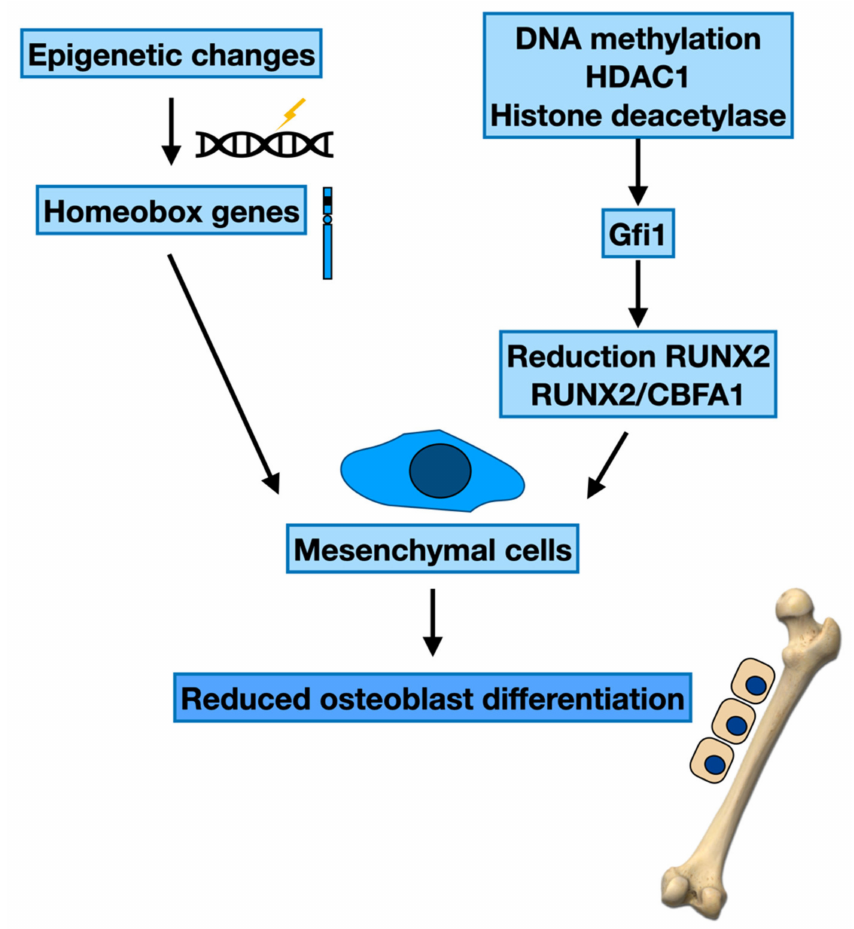
Figure 1. Epigenetic modifications and maturation of